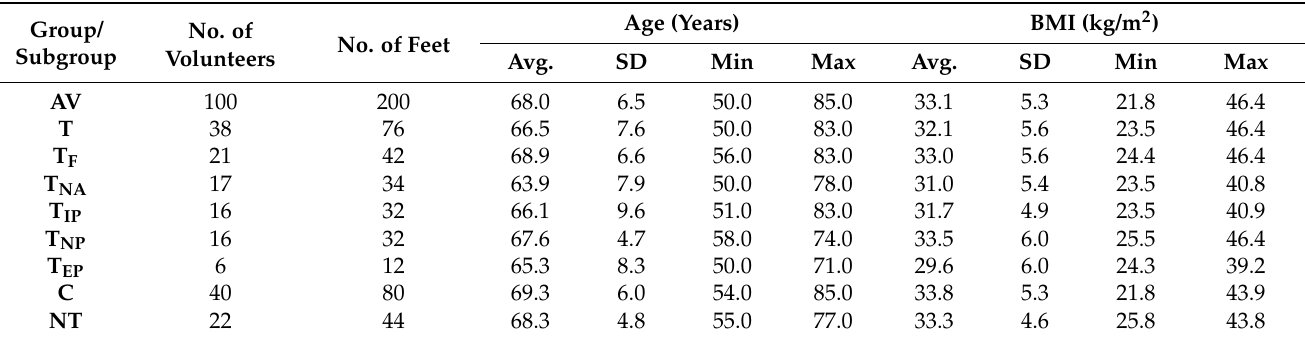
Table 1. Characteristics of the studied groups and